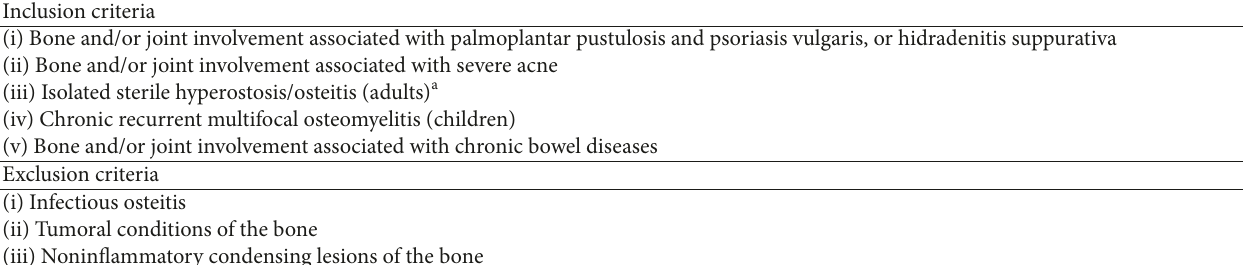
Table 1: Diagnostic criteria for SAPHO syndrome [11, 12].